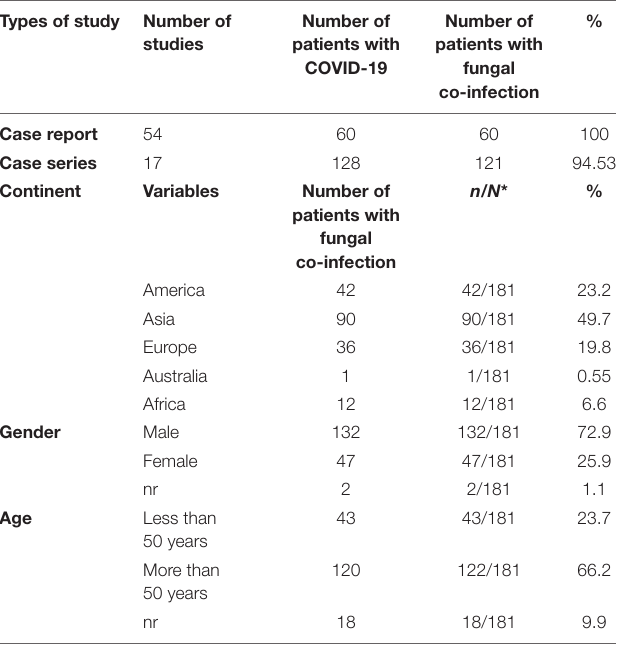
TABLE 3 | Summary of the case reports/case series findings. TABLE 2 | Frequency of fungal co-infection among patients with COVID-19 based on different subgroups. Comorbidities Variables Number of Types of study Number of Number of Number of studies patients with patients with COVID-19 fungal co-infection